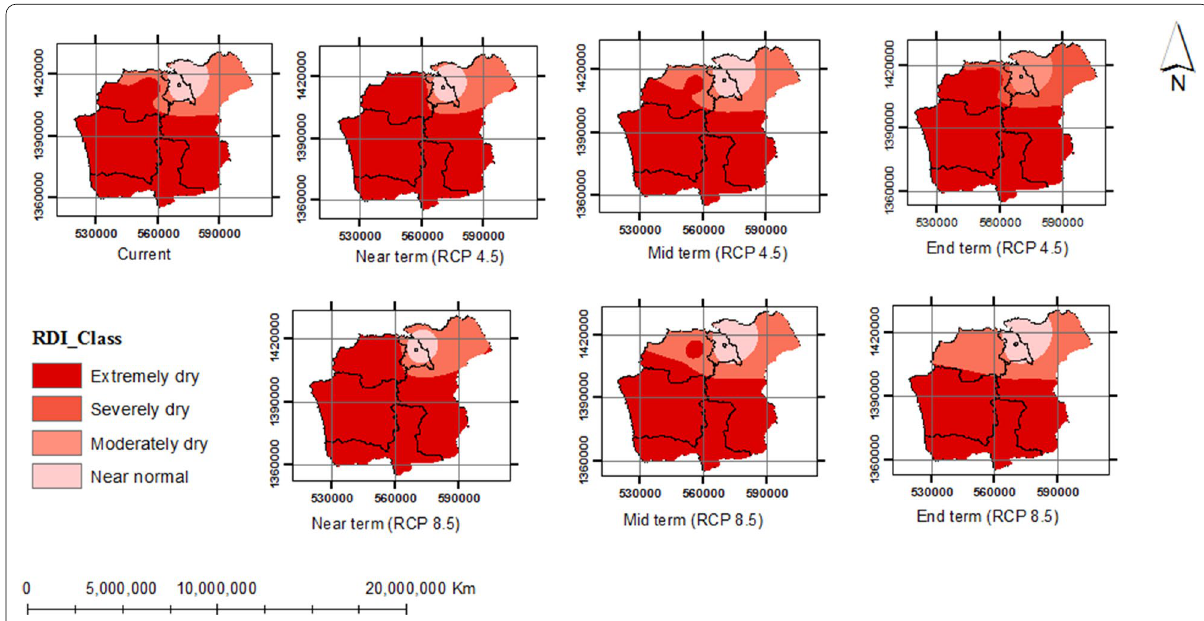
Fig. 3 RDI classes of the driest year of the four